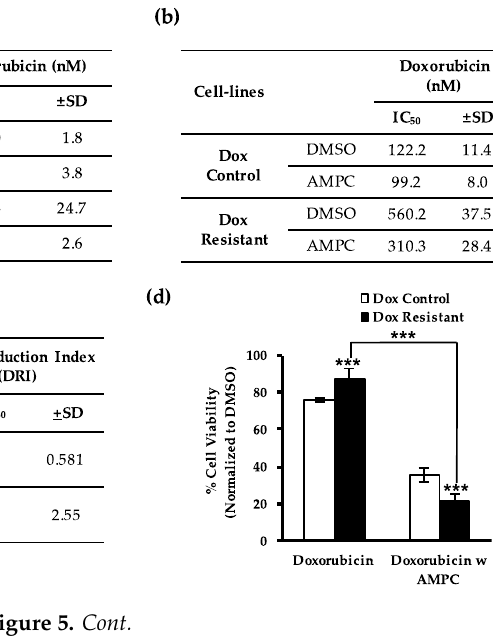
Figure 4. Doxorubicin resistant ER+MC cells exhibit elevated levels of TFF3. ( a–b ) Baseline levels of TFF3 ( a ) mRNA and ( b ) protein levels were analyzed by qPCR and western blot analysis respectively in control and doxorubicin resistant MCF-7 cells. Band intensities were quantified by ImageJ and normalized to input control, where the intensity ratio of doxorubicin control cells was set to 1. Bar charts show means ± standard deviations. * P < 0.05, ** P < 0.01 and *** P < 0.001 (Student’s t-test).